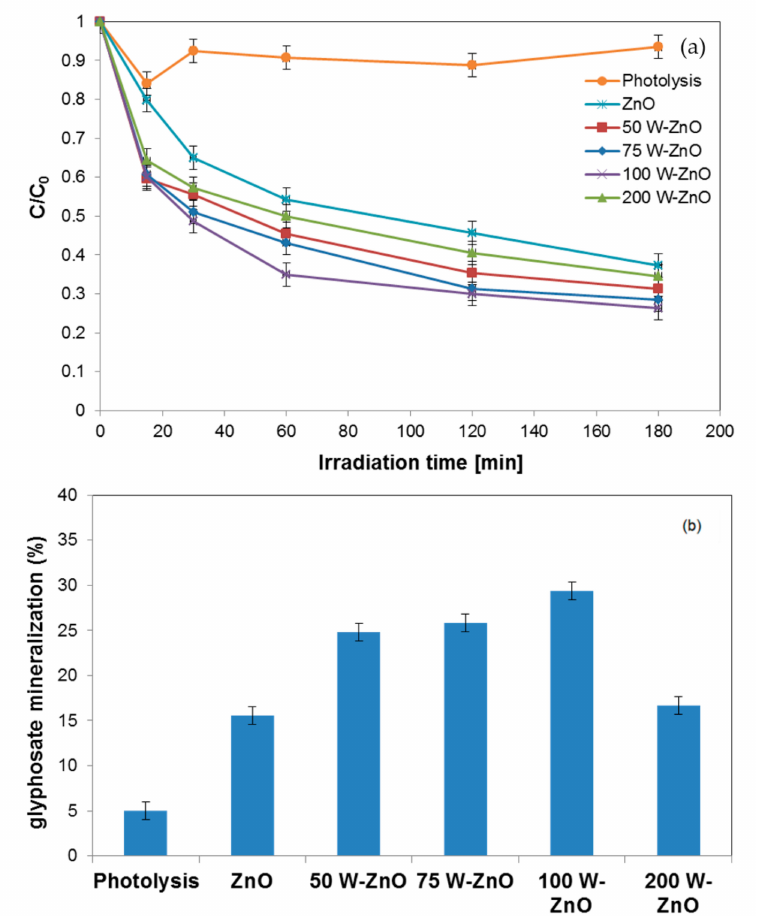
Figure 6. Photocatalytic glyphosate degradation ( a ) and mineralization ( b ) at different W nominal amount under the irradiation time; initial glyphosate concentration: 20 mg/L; pH =